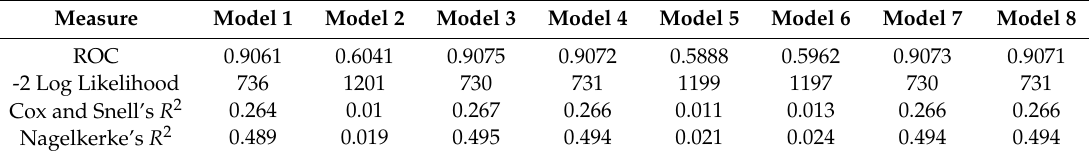
Table 7. Model performance measures for GFC (2007–2009).